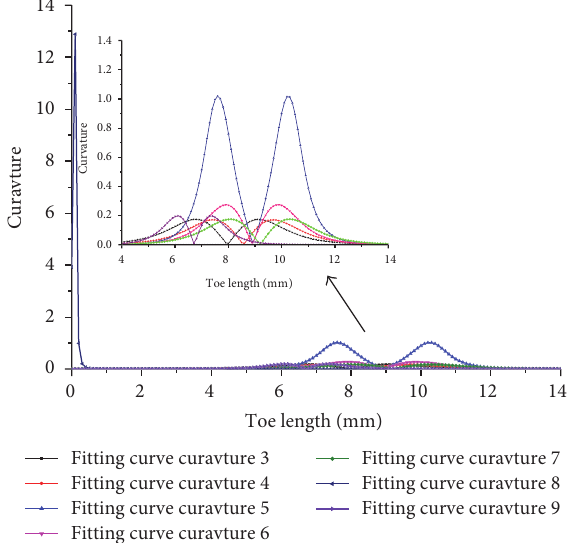
Figure 9: Curvature variation in the fitted curve of the inner side of the